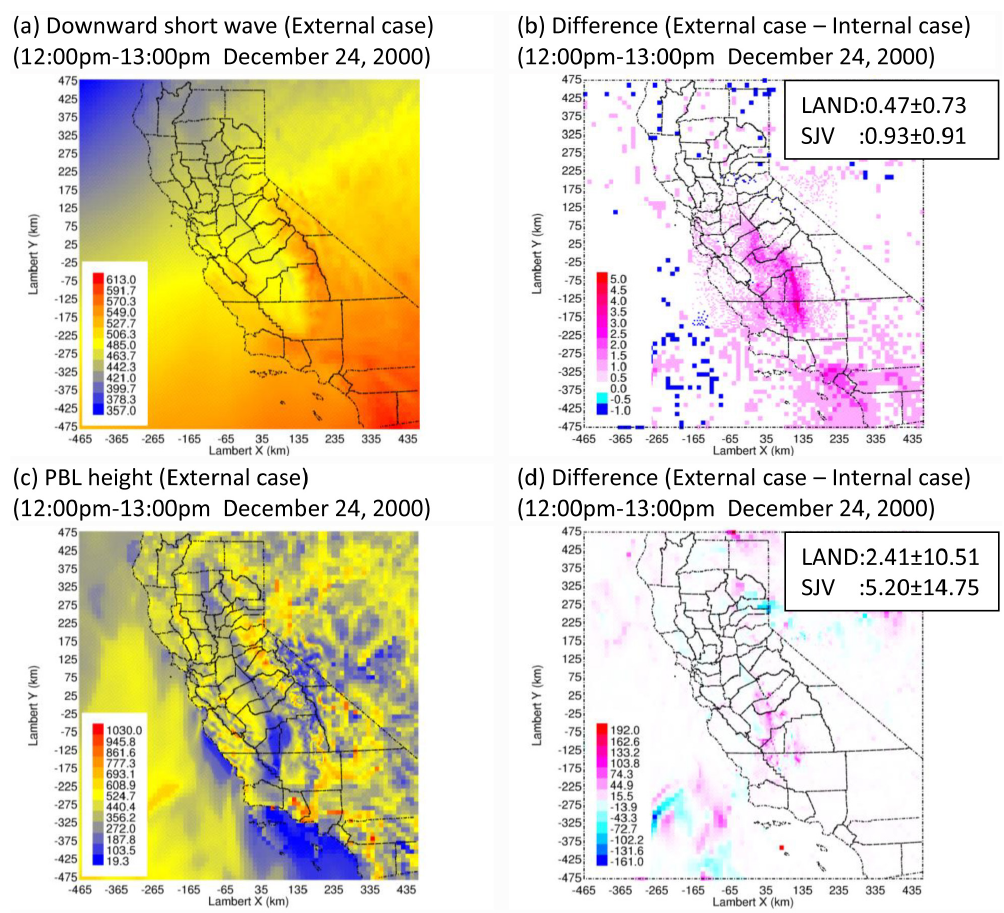
Fig. 6. Clear-sky downward radiation (Wm − 2 ) and PBL height (m) calculated by the external case ( a and c ) and difference between external case and internal case ( b and d ) from 12:00 to 13:00LT on 24 December 2000. Note that the maximum value for each panel is adjusted to best illustrate the spatial patterns. Averaged differences over land and the SJV covered by the 4km domain are shown in the text box.